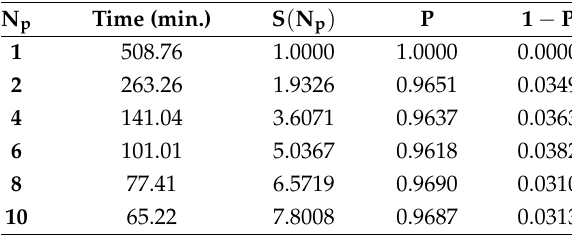
Table 8. Performance metrics for the parallelization of the clustering step.